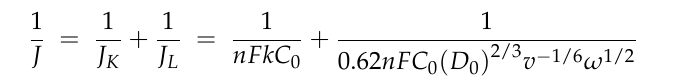
Figure S12: The XPS spectra of Ce-CMO-18%/MWCNTs. Figure S13: The corresponding Tafel plots of Ce-CMO-18%, Ce-CMO-18%/MWCNTs, and MWCNTs. Figure S14: (a) CV curves